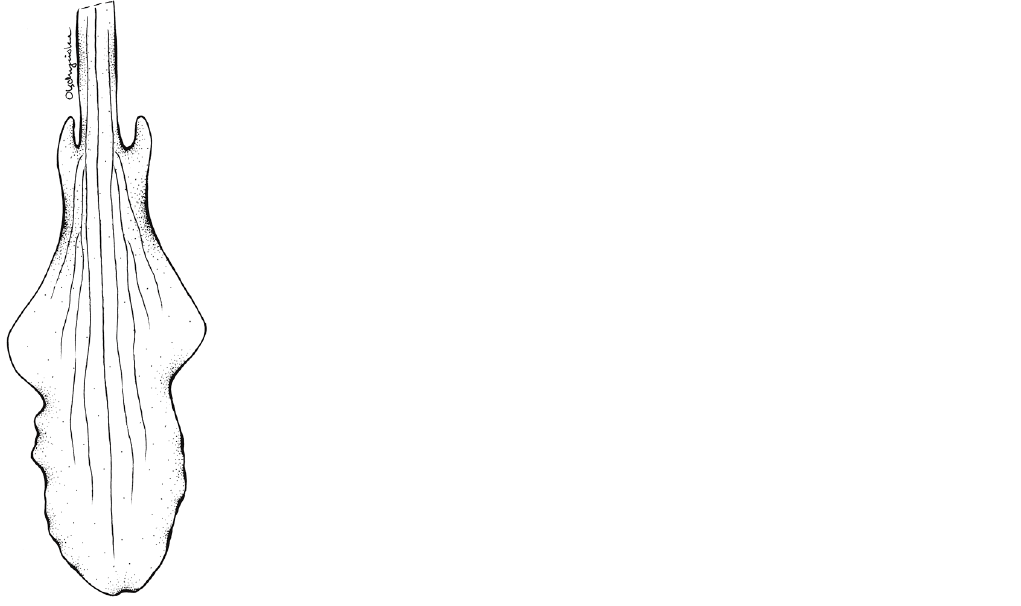
Figure 6. Flower of Schiedeella crenulata—drawn from the holotype (Forderstrom 2592, deposited at AMES). Drawn by N. Ol ę drzy ń ska.